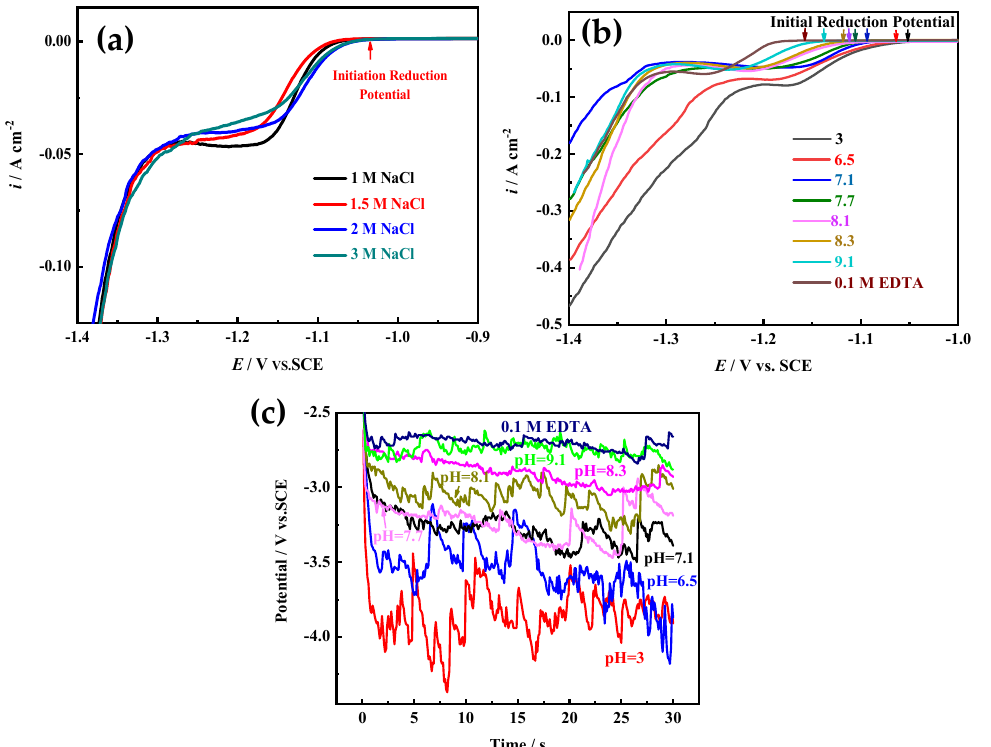
Figure 9. ( a ) The polarization curves of Ni electrodeposition in solutions (pH = 3) with different NaCl concentrations at 10 mV s − 1 . ( b ) The polarization curves of Ni electrodeposition in solutions with different pH values or components at 10 mV s − 1 . ( c ) The chronopotentiometry (CP) curves of Ni electrodeposition in solutions with different pH values or components at − 1 A cm − 2 . Table 2. The density ( ρ ), surface tension ( γ ), and break-off diameter ( d ) of Ni electrodeposition solutions with different pH values and components.